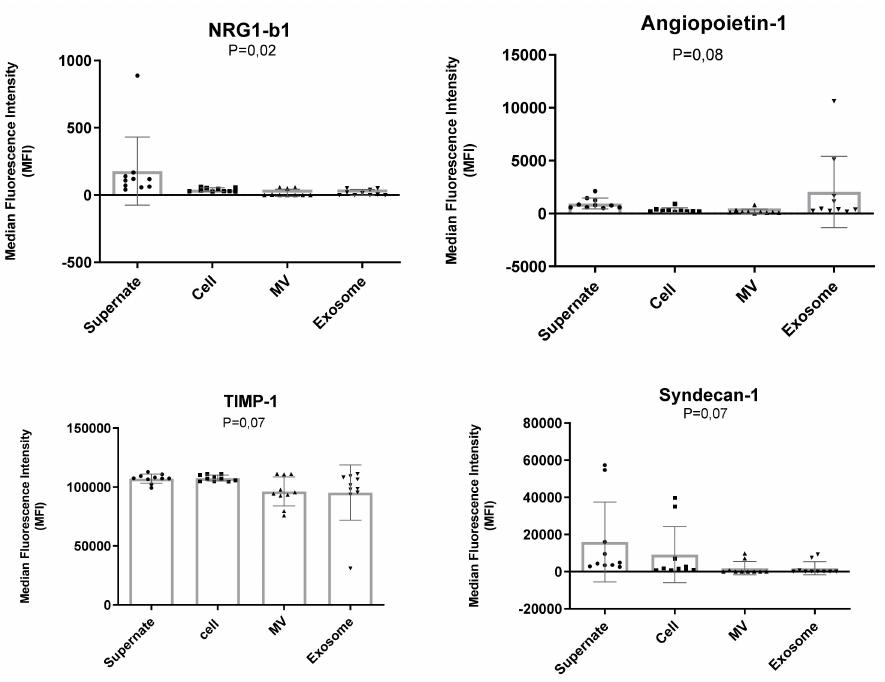
Figure 6. Level of angiogenesis proteins in differential centrifugation fractions of pleural effusion. Levels of Galectin-1, Mesothelin, Osteopontin, VEGF, MMP-7 and HGF were significantly higher in soluble protein when compared with their levels in exosomes. Significance was assessed by two-tailed t -test at p ≤ 0.05.